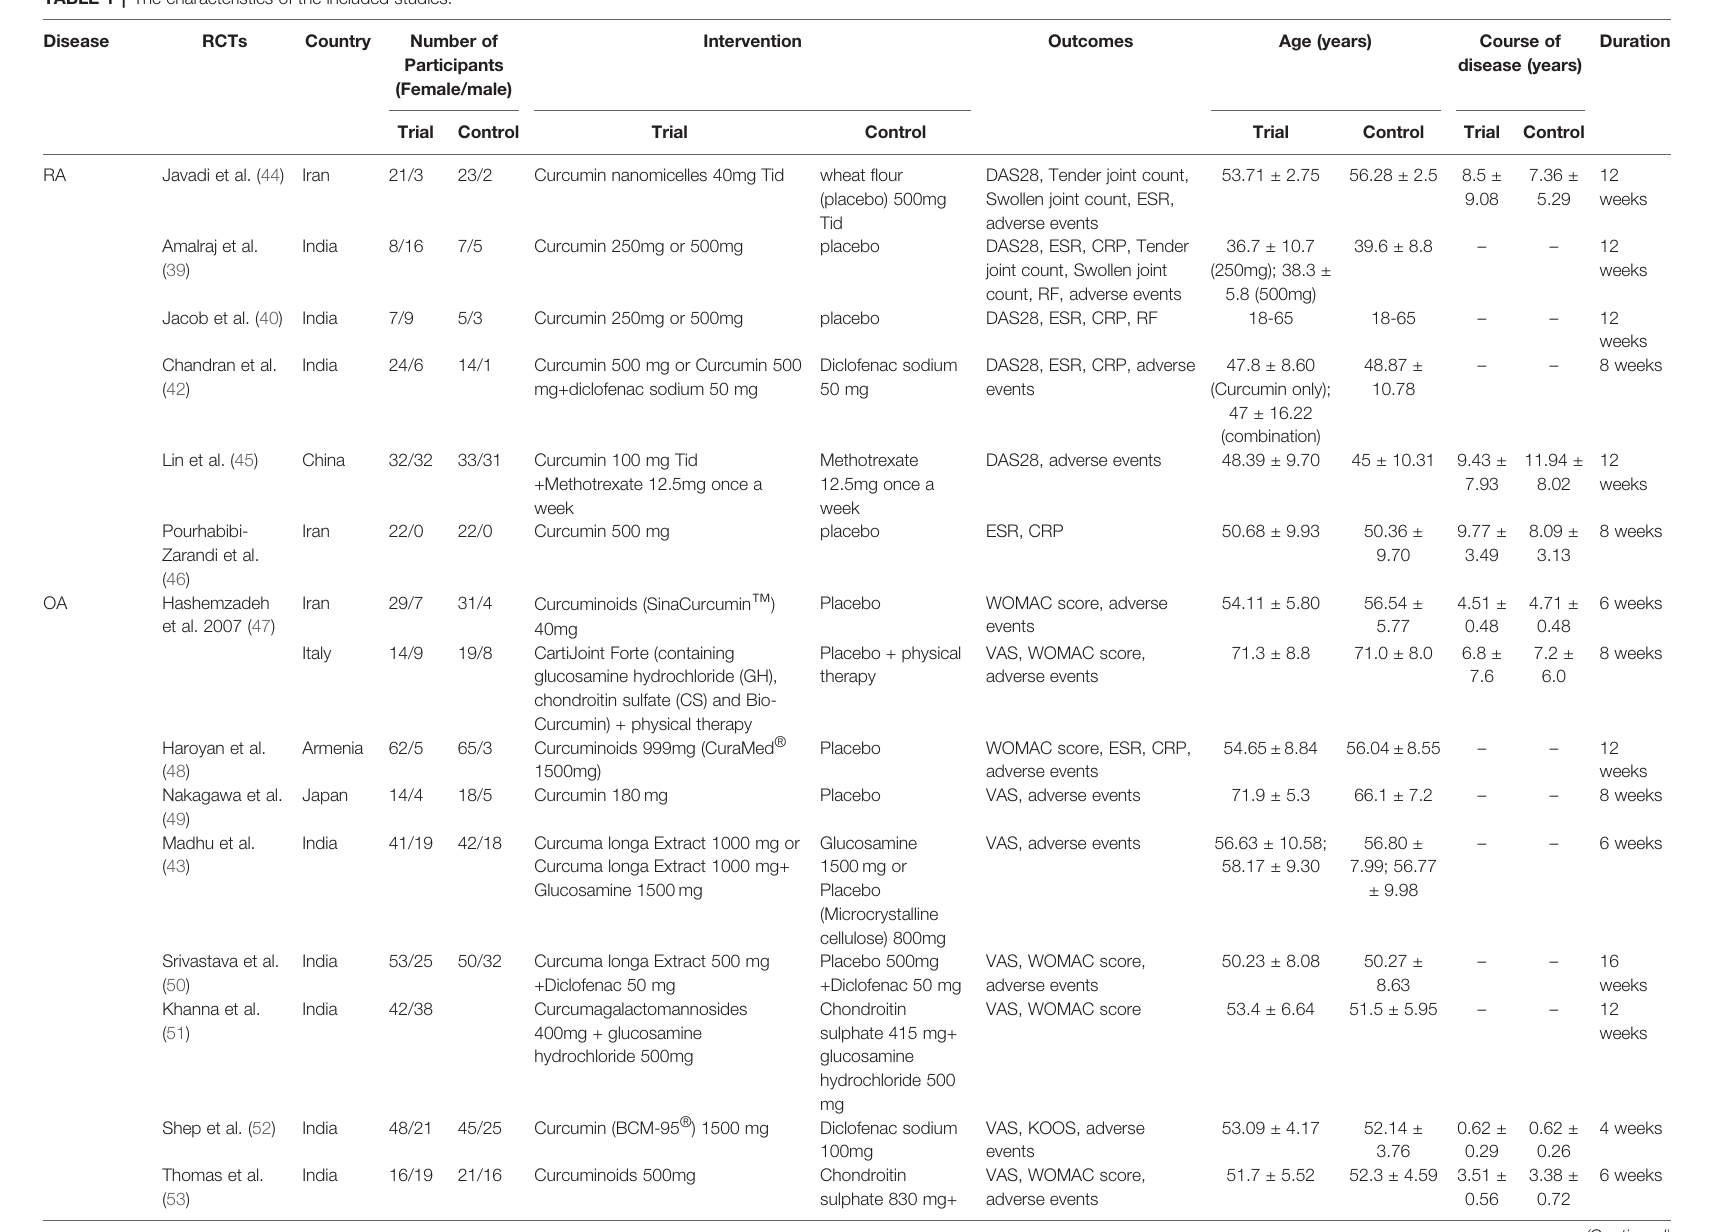
TABLE 1 | The characteristics of the included studies.